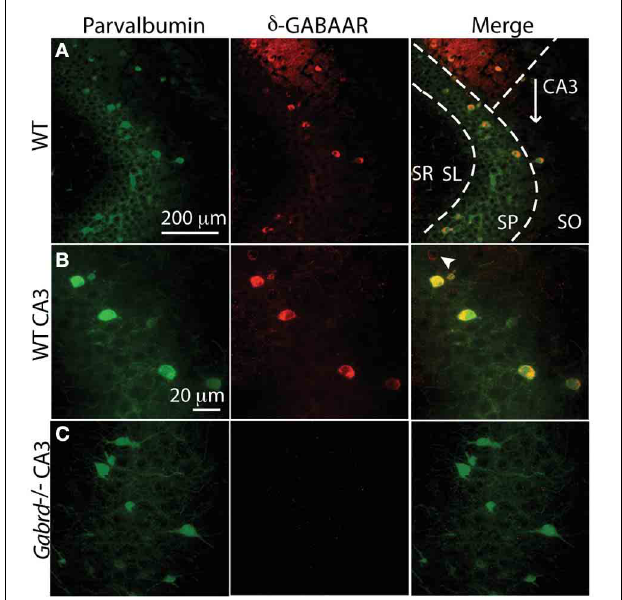
FIGURE 2 | The majority of CA3 PV + interneurons also express δ -GABA δ -GABA A Rs A Rs. (A,B) Immunohistochemical evidence of expression on CA3 PV interneurons in a WT mouse, by confocal microscopy. Green: PV, red: δ -GABA A Rs, yellow: colocalization. (A , B) PV and δ -GABA A Rs immunolabeling is strongest at the somata and it is clearly present and more faint in the processes around CA3 pyramidal cells. Most PV + INs in the stratum pyramidale (SP) also co-localize δ -GABA A Rs; very rare interneurons are δ -GABA A Rs + and PV + ( B , white arrowhead). Most CA3 PV + and/or δ -GABA A Rs + INs are concentrated around the SP, whereas they are sparser in stratum oriens (SO) stratum lucidum (SL) and stratum radiatum (SR). (C) Specificity of δ -GABA A Rs immunolabeling is confirmed by the lack of δ -GABA A R staining in a Gabrd − / − mouse. No significant change in PV labeling is found in Gabrd − / −